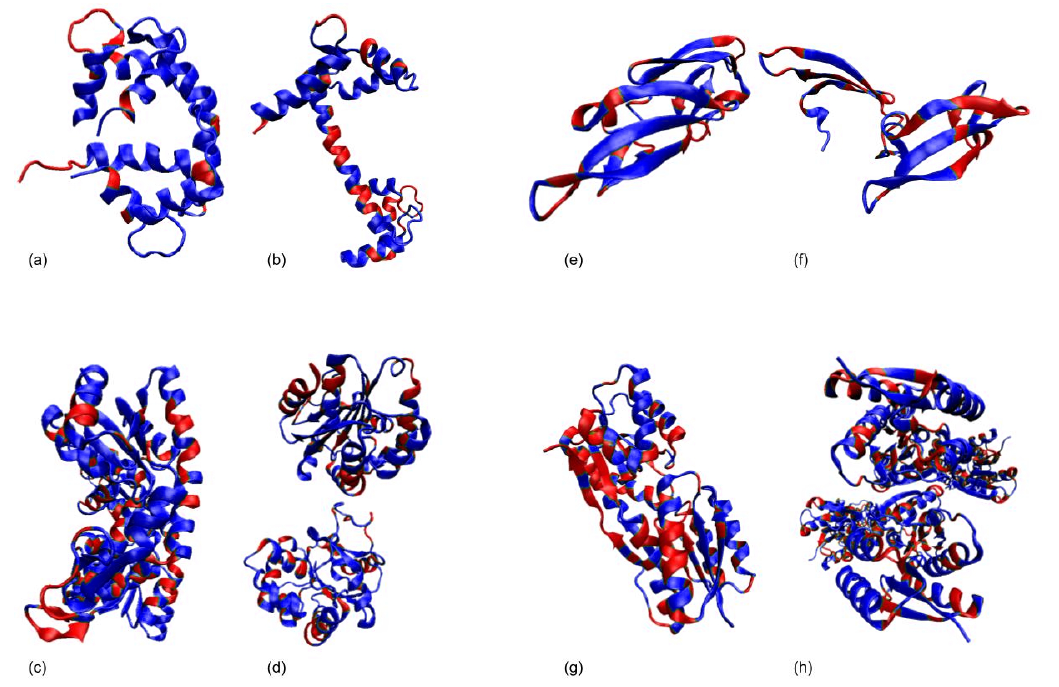
Figure 2. Open and closed conformations of sample proteins. Rigid residues produced by the Kinari software are shown in red, and flexible residues are shown in blue. ( a ) CaM Closed conformation, 1 CTR . ( b ) CaM Open conformation, 1 CLL . ( c ) AdK Closed conformation, 4 AKE . ( d ) AdK Open conformation, 1 AKE . ( e ) CVN closed conformation, 2 EZM . ( f ) CVN closed conformation, 15 LE . ( g ) RBP closed conformation, 2 DRI . ( h ) RBP open conformation, 1 URP .